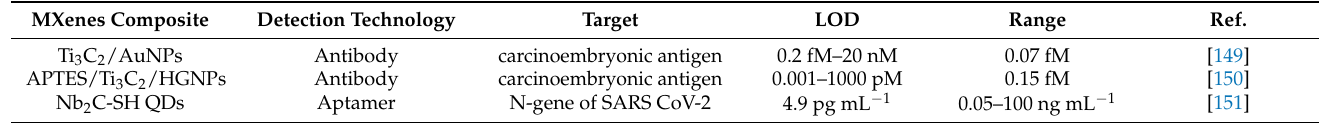
Table 9. MXene-based SPR biosensors identify units, target, and analytical